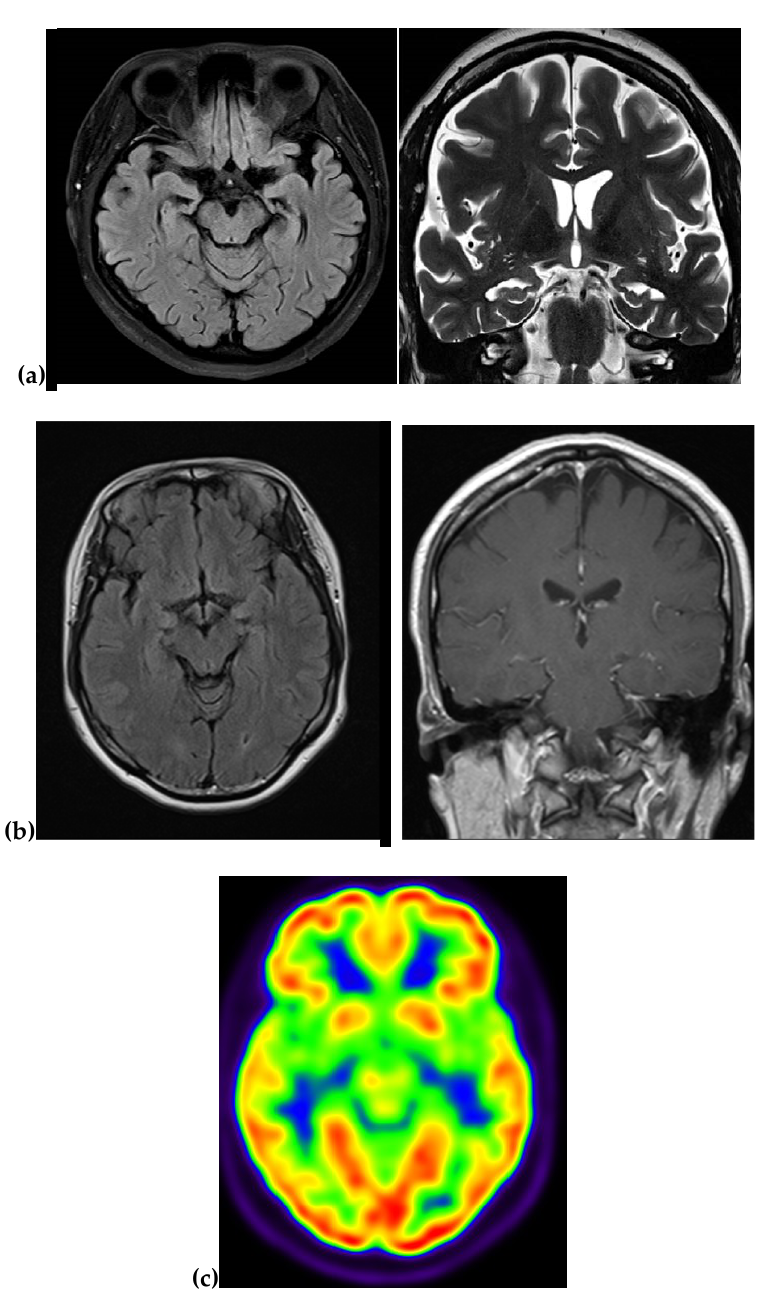
Figure 7. ( a ) MRI data of proband patient of Family 1. Atrophy could be seen in the right temporal and parietal regions. A vascular abnormality also appeared in the left frontal area. ( b ) MRI data of proband patient of Family 2. ( c ) PET data from Family 2.